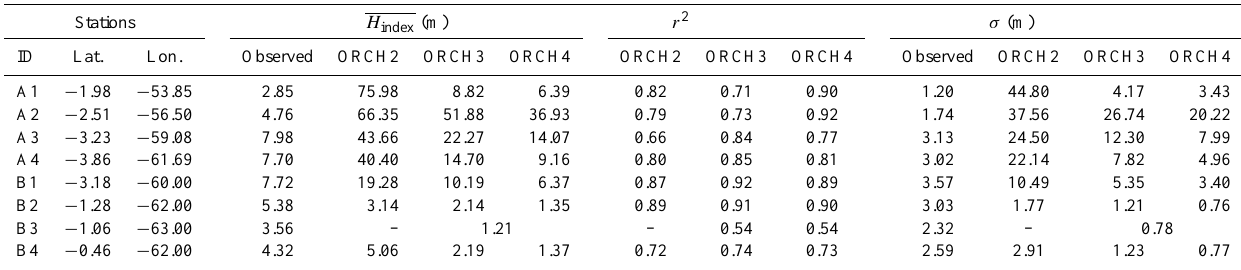
Table 8. Comparison of the water height index H index (m) between simulations ORCH2 to ORCH4 and observations, in 4 locations on the mainstem (ID A) and 4 locations on the Rio Negro-Branco (ID B) (see Fig. 16 for locations), for the time period 1993–2000. Monthly mean correlation coefficient r 2 and monthly standard deviation σ are given.